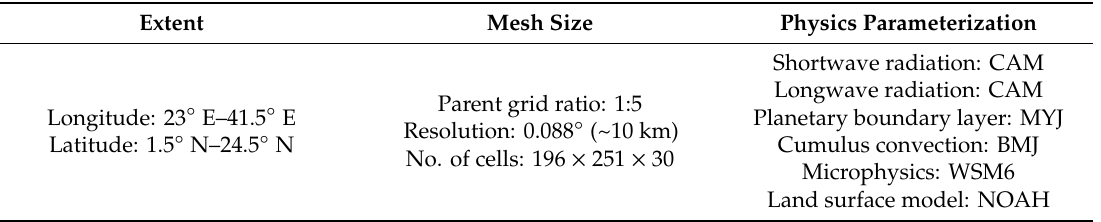
Table 1. Weather research and forecasting (WRF) model configuration parameters for the Eastern Nile Basin (ENB) domain. (CAM: Community Atmospheric Model; MYJ: Mellor-Yamada-Janjic scheme; BMJ: Betts-Miller-Janjic scheme; WSM6: WRF Single Moment 6 classes; NOAH: Noah land surface